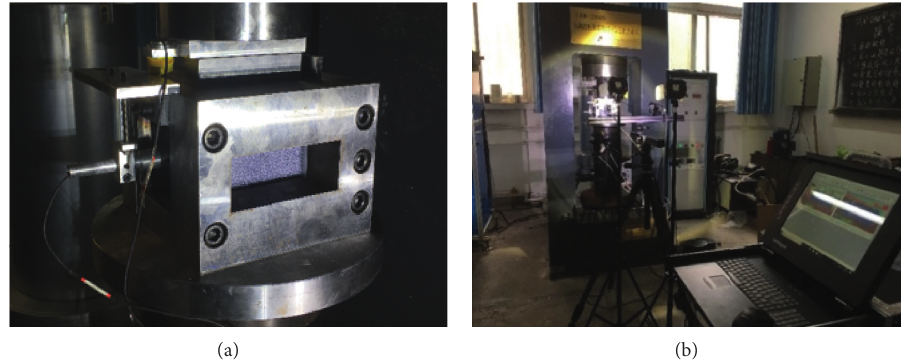
Figure 7: Test systems. (a) Rock wall chamber. (b) Damage measurement process.